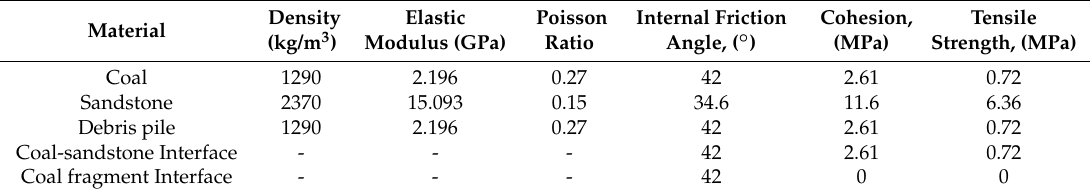
Figure 4. The numerical simulation design and results: ( a ) scheme of model prototype; ( b ) simulation result that the pile height equals to the pillar height; and ( c ) simulation result that the pile height is smaller than the pillar height. Table 1. Mechanical properties of the